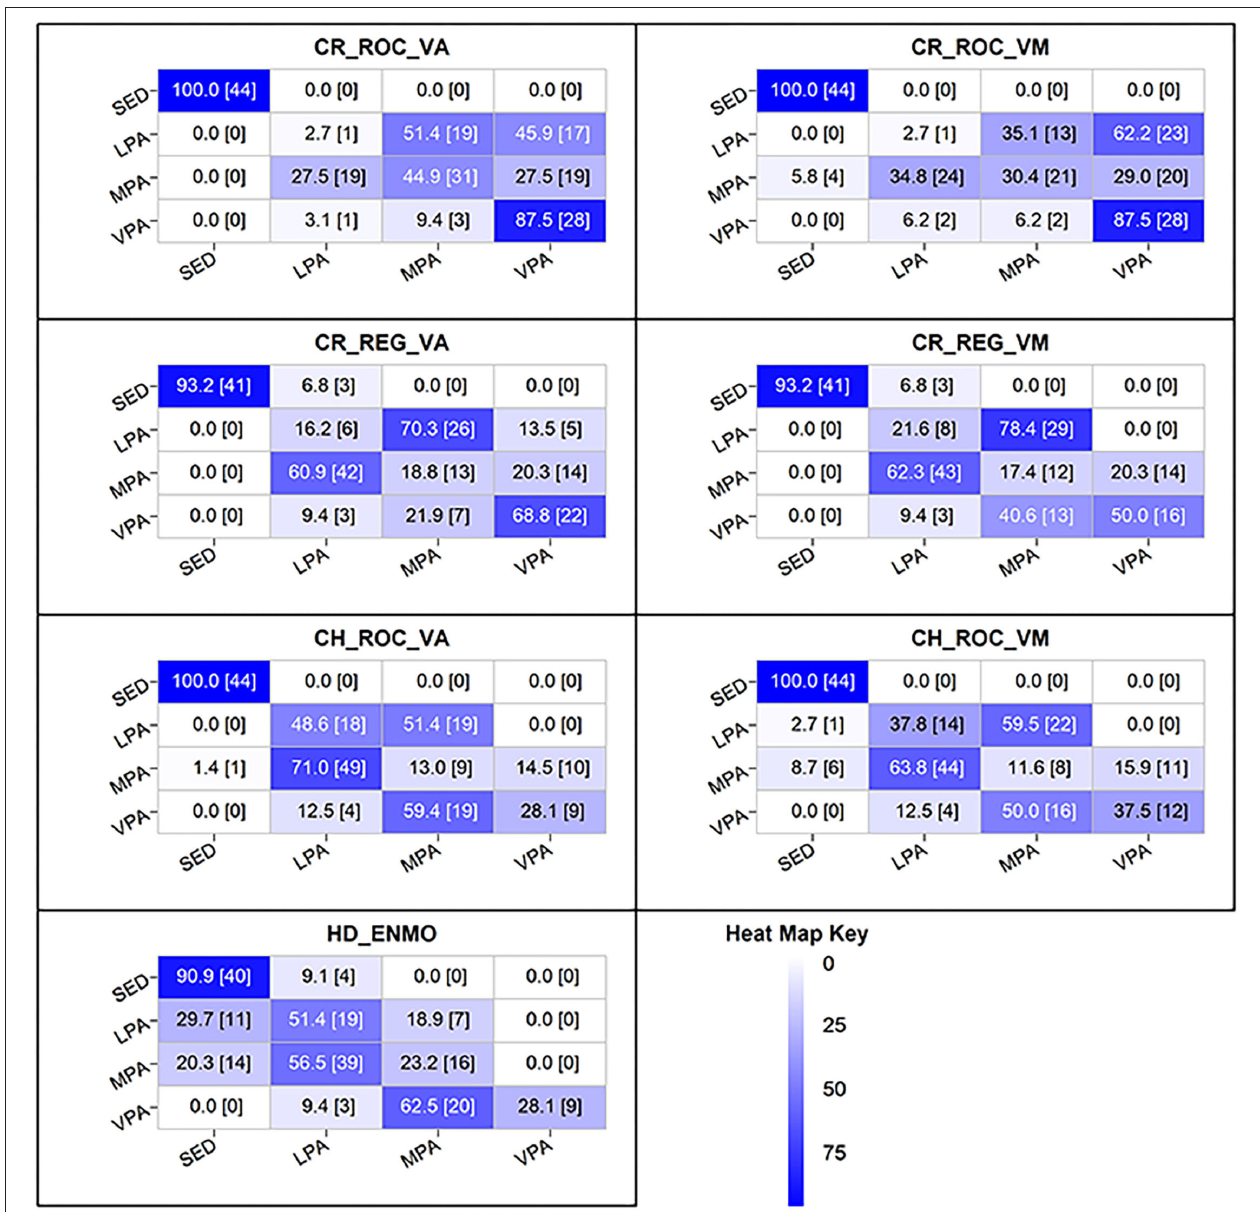
FIGURE 2 | Heat map confusion matrices for the youth specific ActiGraph cut-points for the wrist. Diagonal = correct predictions; Columns = predictions; Rows = measured by portable calorimetry.